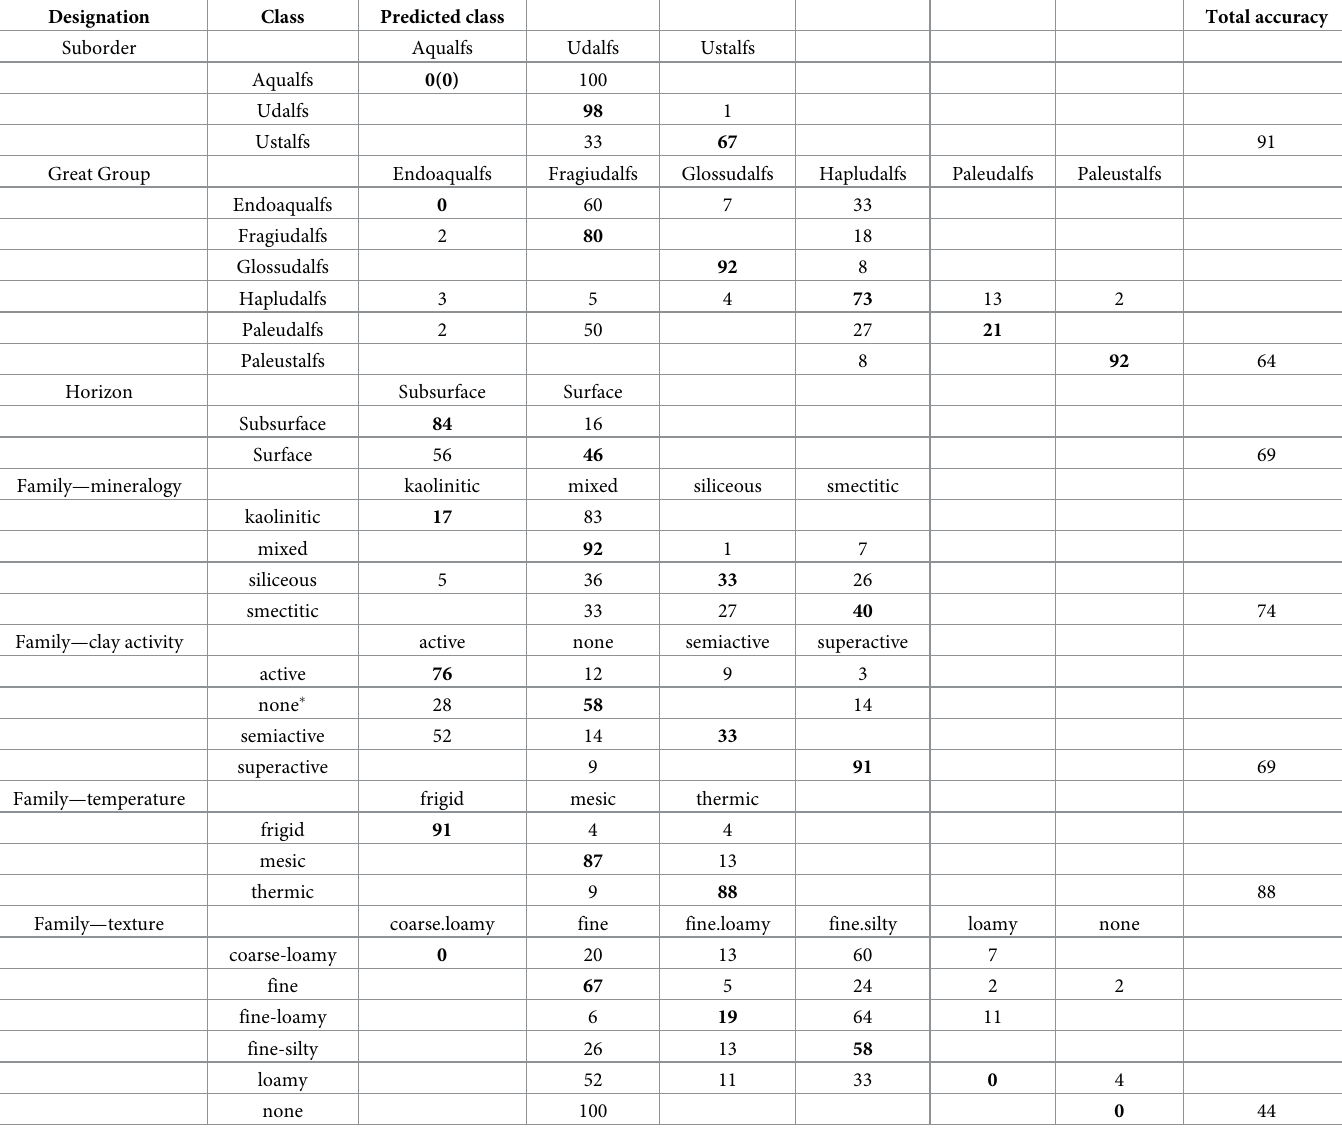
Table 2. Misclassification matrix from linear discriminant analysis testing of the accuracy of PCA (containing 5-PCs) model to predict the membership of the Alfi- sols based on the water-extracted (WE) compositional data. Percent correct classifications are shown on the diagonal (in bold) while percent misclassification samples are shown